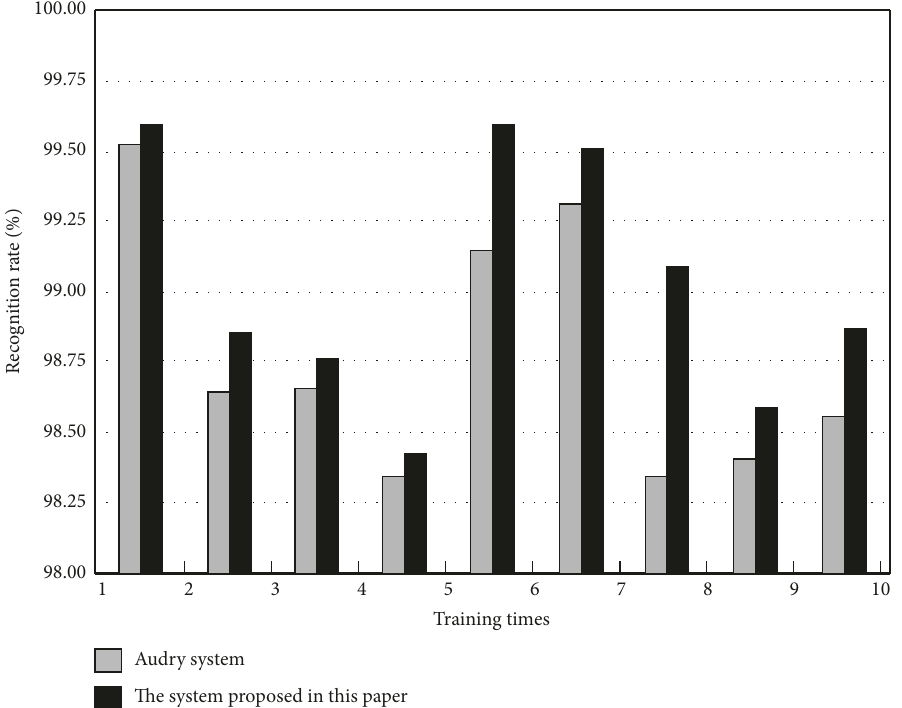
Figure 6: Comparison of the evaluation rates between the Audry system and the system proposed in this